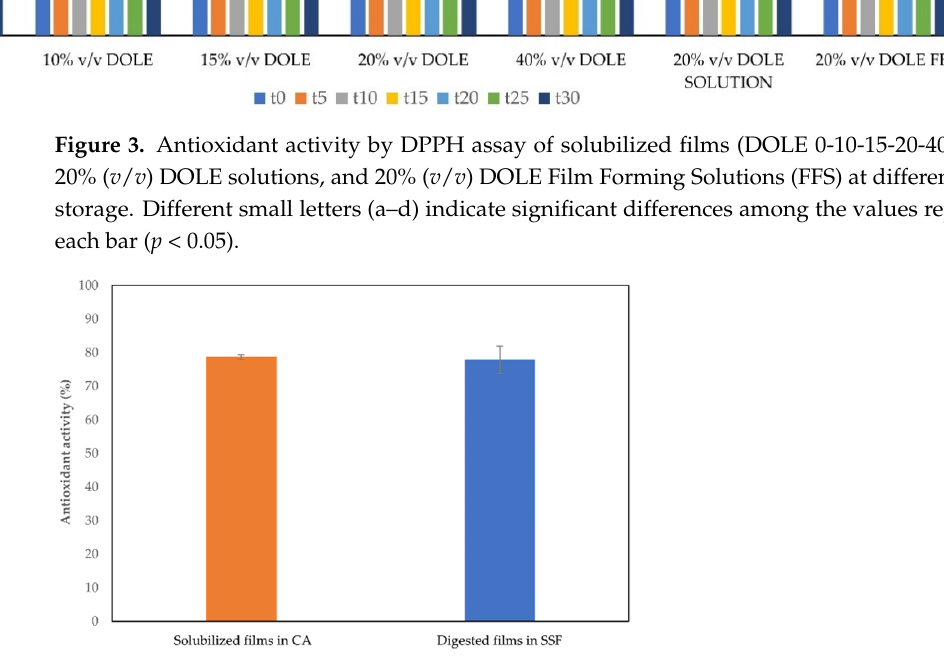
Figure 5. Properties of chitosan-based films with different % ( v / v ) of DOLE (0–40%). On the top: from left to right Tensile Strength and Elongation at Break. On the bottom: from left to right Young’s